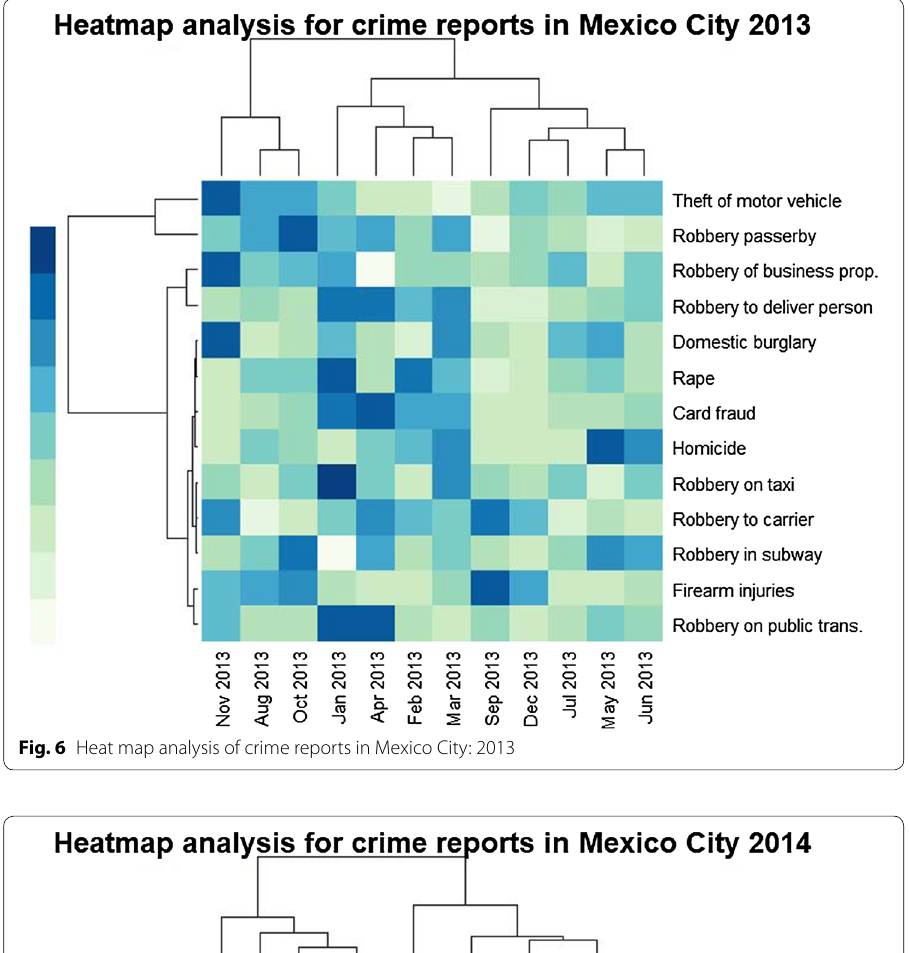
Fig. 6 Heat map analysis of crime reports in Mexico City: 2013